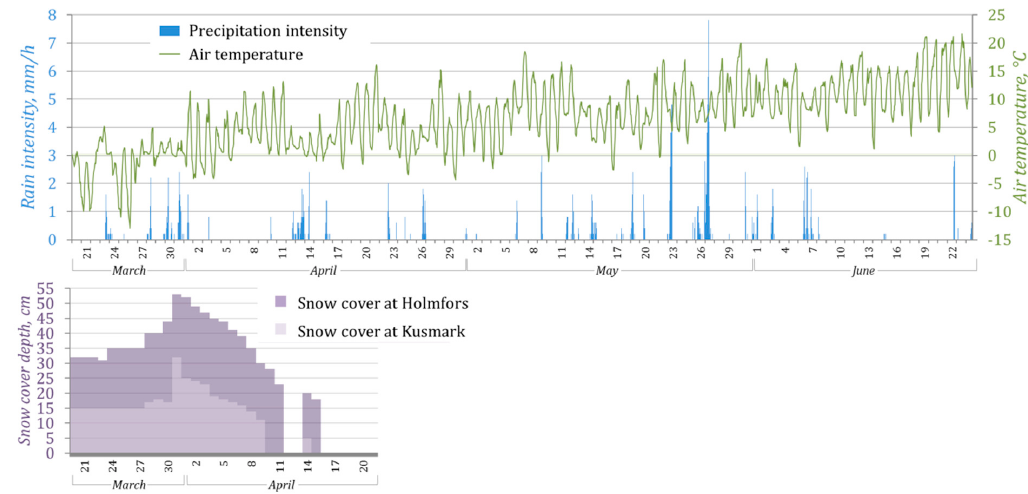
Figure 3. Weather data from the study site during the monitoring campaign. Top : precipitation intensity and air temperature. Bottom : snow cover depth at Holmfors and Kusmark weather stations. Daily snow cover depth measurements with 1 cm resolution were obtained from the Swedish Meteorological and Hydrological Institute [25] from Kusmark and Holmfors stations, 14.6 km NNW and 16.4 km WNW from the DTS unit in the study area, respectively.